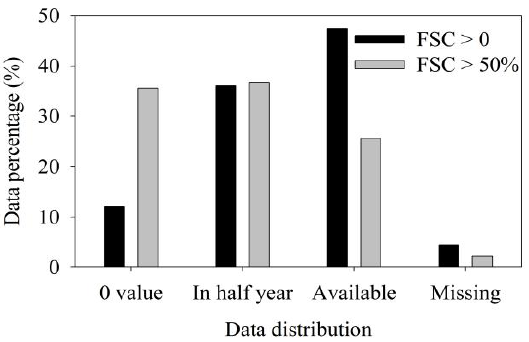
Figure 2. The percentage of phenology data distribution on the threshold of fractional snow cover (FSC) >0 and FSC >50% based on the threshold of snow depth ≥ 1 cm during 2000–2010. Note: 0 value, no snow cover phenology was detected in at least one of the two data sets (i.e., in-situ data and MODIS data); in half year, both the snow starting time and snow ending time was detected in a